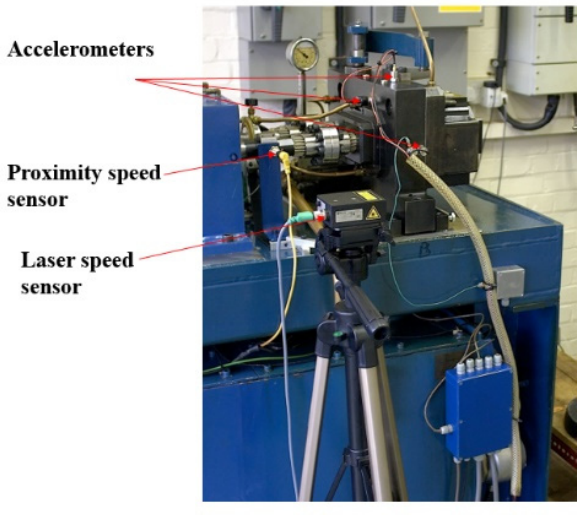
Figure 1. Gear test rig: an experimental setup.